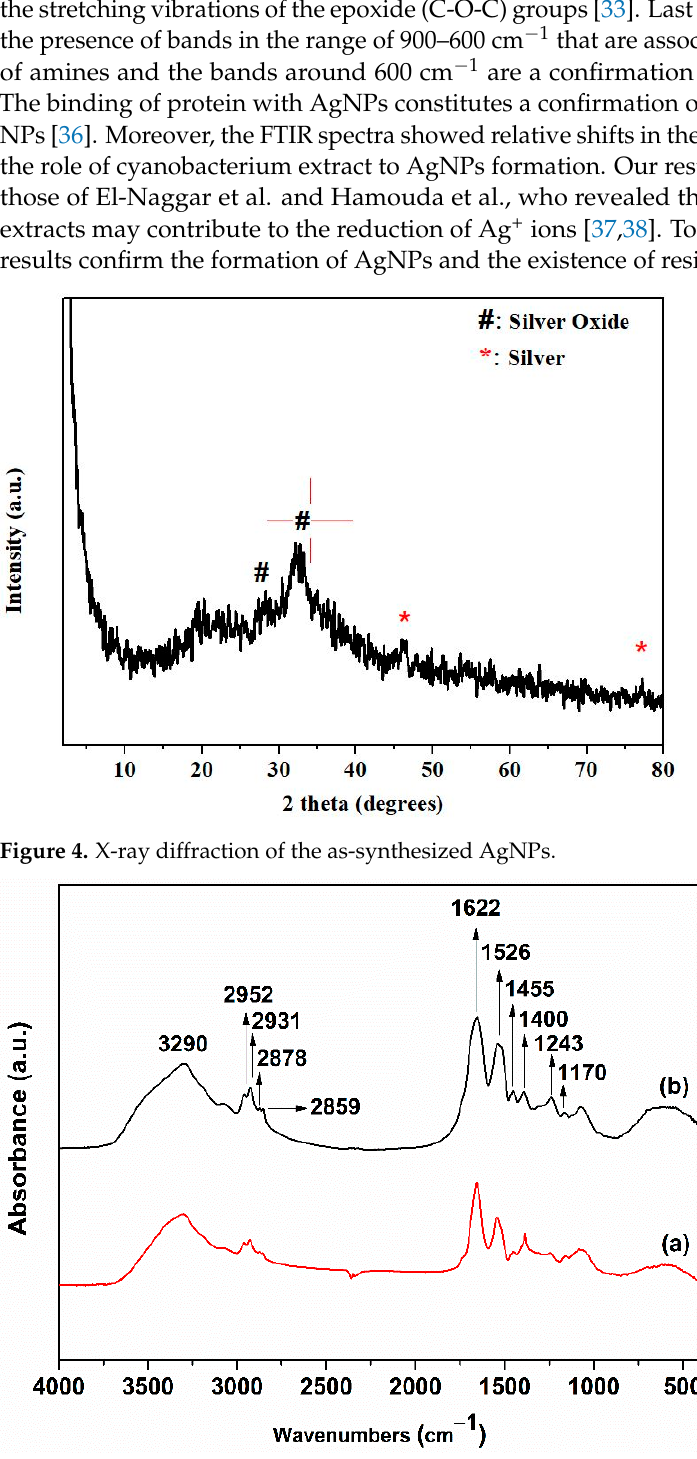
Figure 5. FTIR spectra of ( a ) Pseudanabaena/Limnothrix sp. cells and ( b ) synthesized AgNPs. Each peak in the spectrum of the synthesized AgNPs represents a specific molecular vibration. The corresponding functional groups are shown in the spectra.